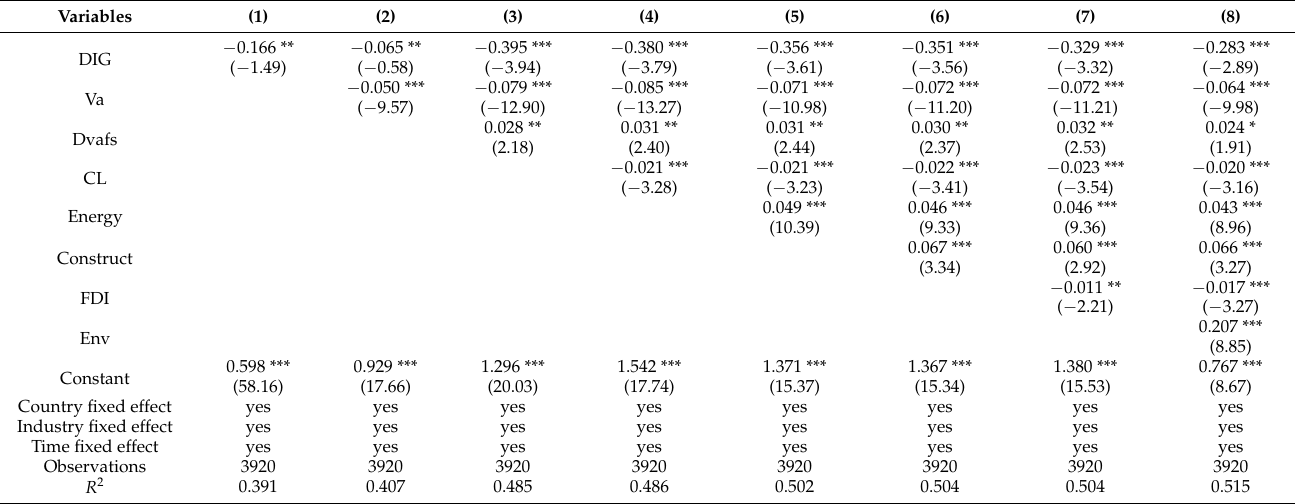
Table 3. Benchmark regression results.